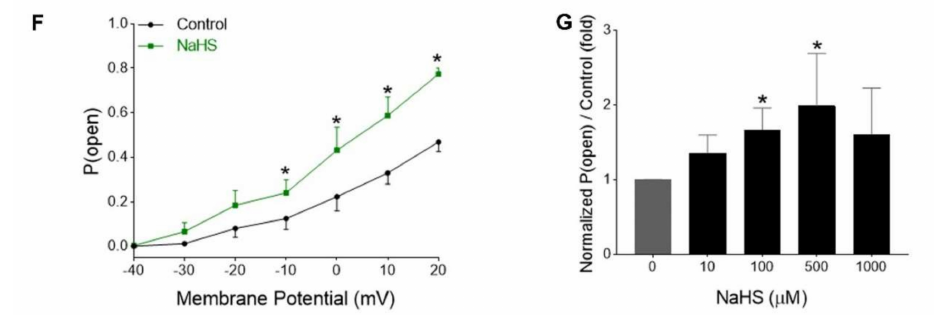
Figure 3. H 2 S activation of BK Ca in hUASMC. ( A ) Representative sweeps of voltage-dependent currents in control (black), TEA (red), H 2 S doner NaHS (green), and NaHS + TEA (blue) groups. NaHS increased whole-cell currents (green), and TEA blocked NaHS-induced currents (blue). ( B , C ) Current densities in control ( n = 10), NaHS ( n = 10), TEA ( n = 5), and NaHS + TEA ( n = 5) groups. * p < 0.05, NaHS vs. control; ### p < 0.001, TEA vs. control. In addition to TEA-sensitive channels, NaHS also activated TEA-insensitive channels. # p < 0.05 TEA vs. NaHS + TEA. ( D , E ) Representative outside-out single-channel currents of BK Ca in baseline, NaHS, and washout with standard bath solutions at holding potential of + 40 mV and with 10 µ M free Ca 2 + in the pipette solution. ( F ) P open of BK Ca was also augmented in lower membrane potentials of − 10 mV to + 20 mV ( n = 6 in control and n = 4 in NaHS groups). * p < 0.05, vs. control. ( G ) Dose–response of NaHS on BK Ca channel activity. n = 10 / group. c: indicates the close state of